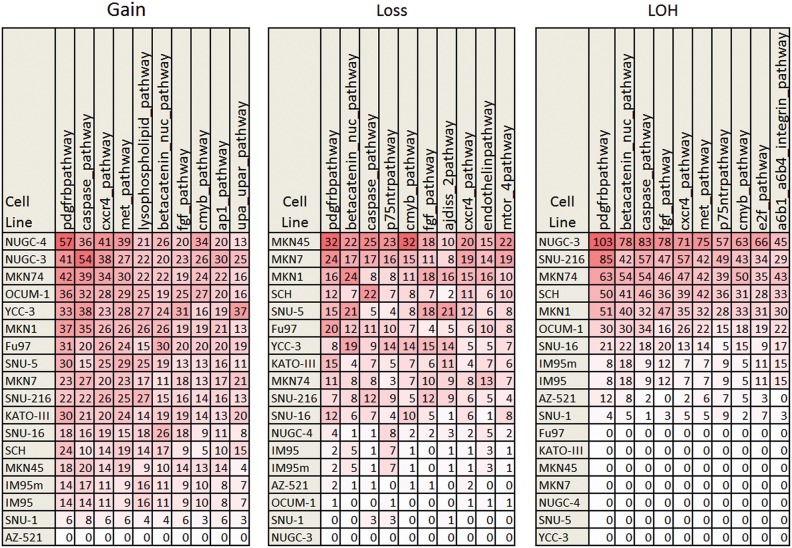
Top 10 cellular pathways having the most genetic aberrations in the Asian gastric cell lines.The numerics in red boxes are the number of aberrations. Increased intensity of red corresponds to increased number of aberrations.